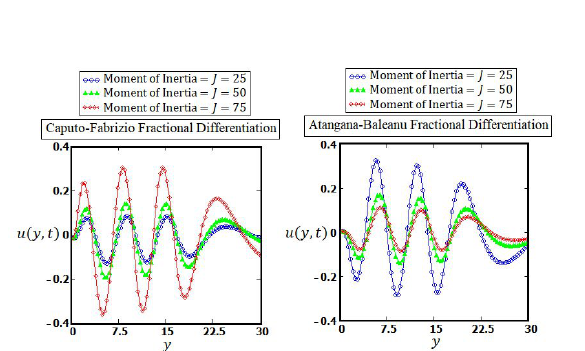
Figure 3: Graph of displacement via CF and AB fractional operator with three different variants of moment of inertia J .